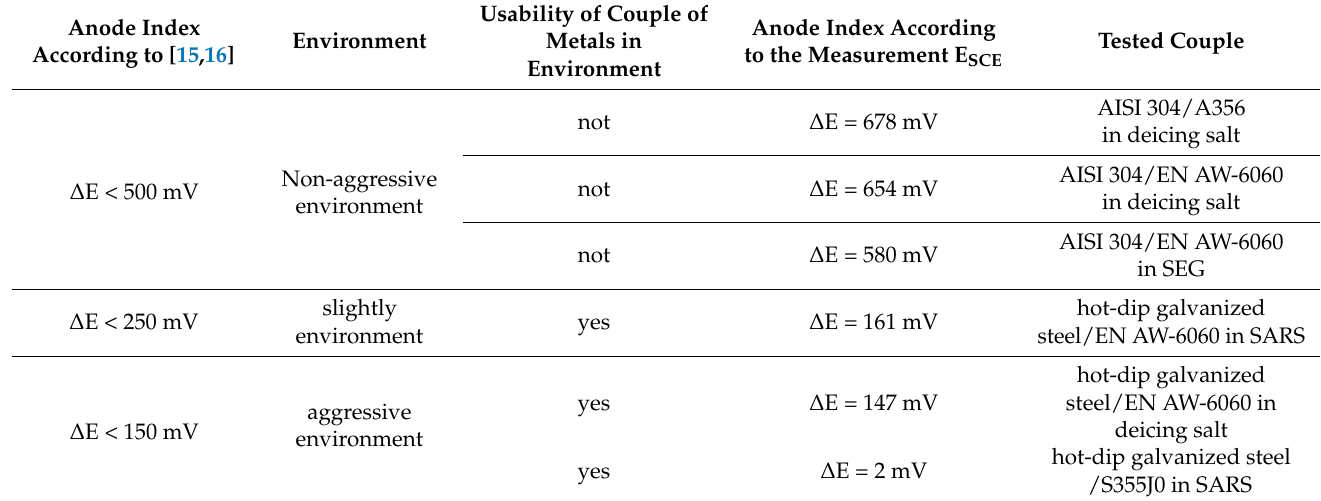
Table 5. Usability of bimetallic corrosion of different metals in the environment. Anode Index Ac- cording to [15,16]